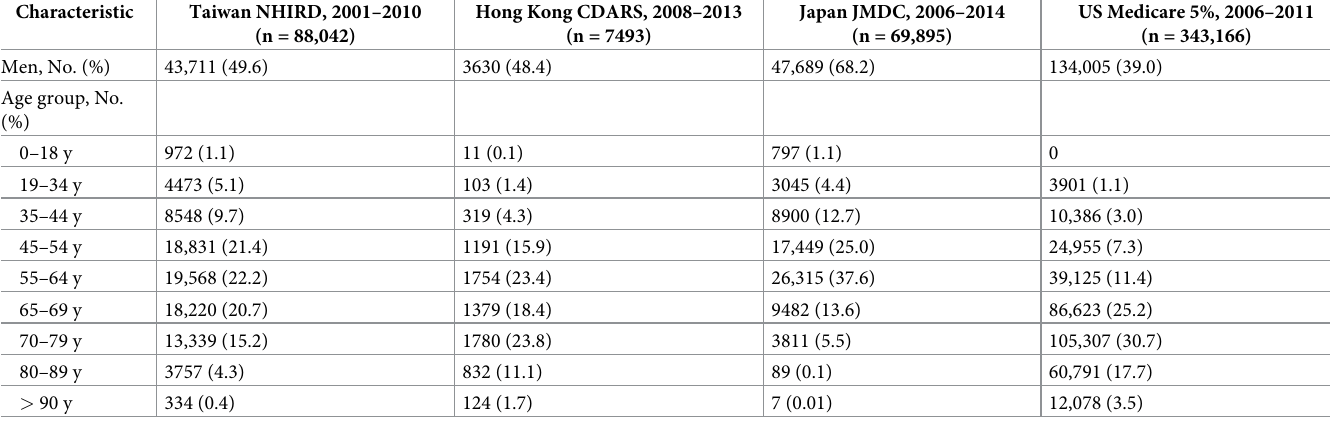
Table 1. Age and sex distribution of patients with type 2 diabetes in Taiwan, Hong Kong, Japan, and the United States.